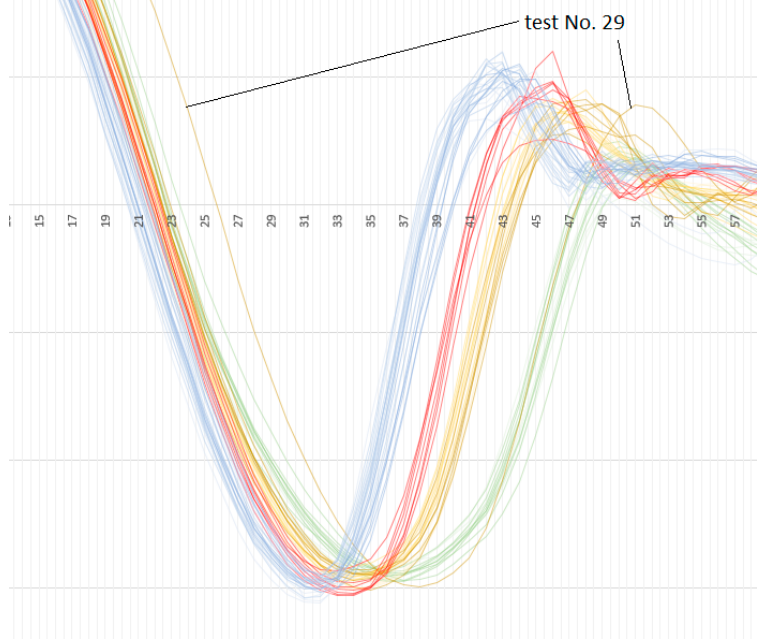
Figure 10. The curve of the test No. 29—out of phase.